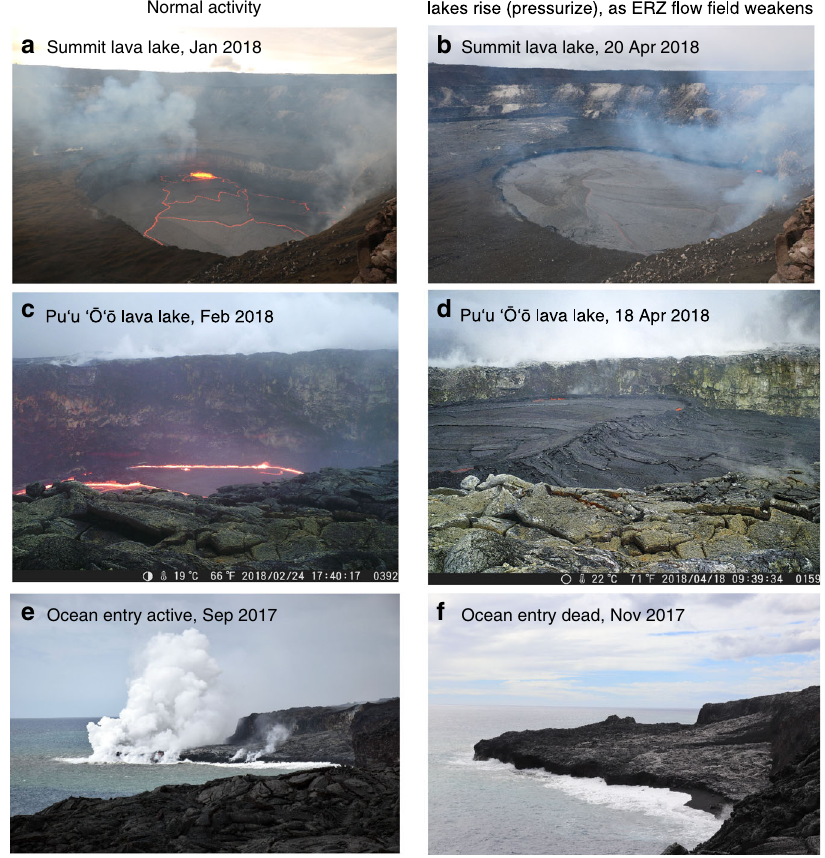
Fig. 5 Visual observations of changes preceding the 2018 eruption. a Normal summit lava lake levels vs. b unusually high lake levels due to pressurization in April 2018. The lake is ~300 m long. c Normal lava lake elevation in Pu ʻ u ʻ Ō ʻ ō vs. d unusually high lake elevation due to pressurization in April 2018. The lake is ~50 m long. e Ocean entry activity typical of the preceding year, with numerous lava streams and a moderate steam plume vs. f an inactive ocean entry in November 2017 as East Rift Zone (ERZ) surface breakouts retreated